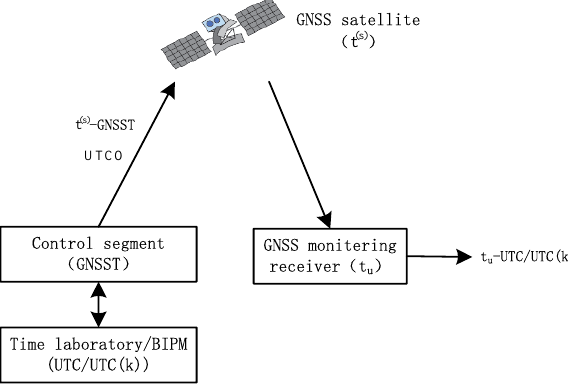
Figure 1. Principle of GNSS timing.